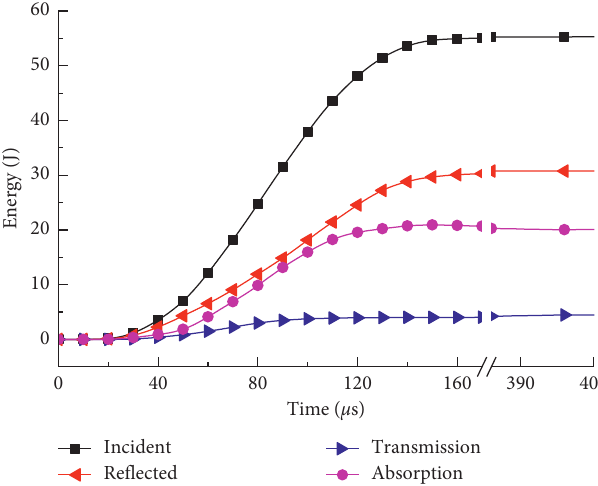
Figure 15: Time history curve of energy change of SHPB compression test of limestone specimen.